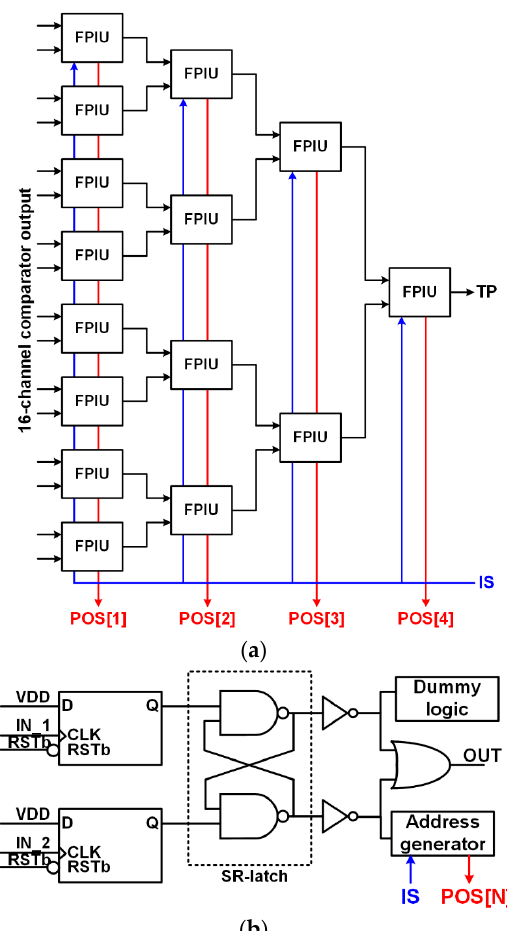
Figure 5. Block diagrams of ( a ) the asynchronous fastest signal identifier (AFSI) and ( b ) the faster pulse identification unit (FPIU).